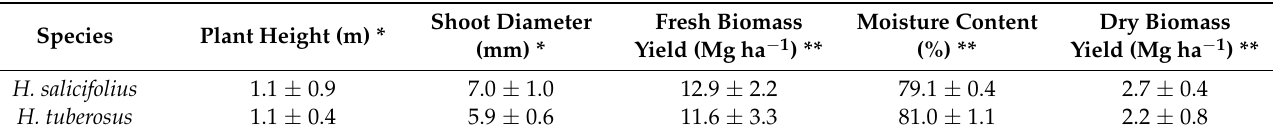
Table 1. Biometric features, moisture content, and yield of fresh and dry biomass of H. salicifolius and H. tuberosus .